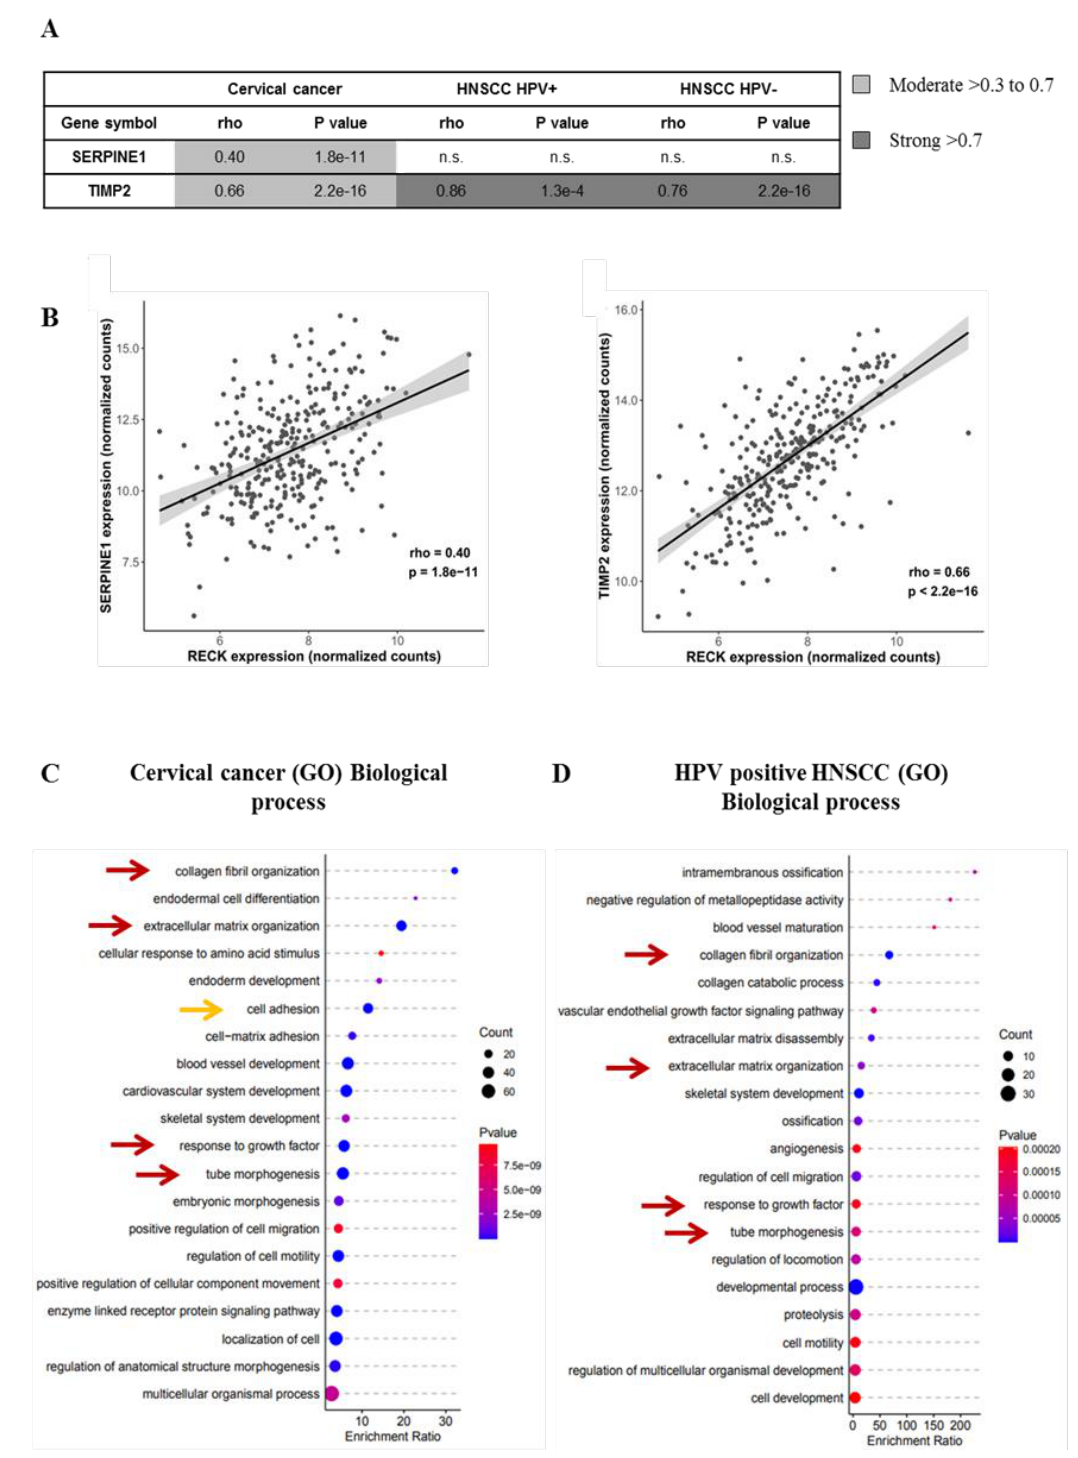
Figure 6. Extracellular matrix remodeling is one of the most enriched biological processes associated with RECK expression in both cervical cancer and HNSCC patients. ( A ). Correlation between SerpinE1 or TIMP2 mRNA levels and RECK mRNA expression in cervical cancer and HNSCC clinical samples deposited in TCGA platform. ( B ). Representative image of SerpinE1 and TIMP2 correlation with RECK expression in cervical cancer. Spearman’s correlation analyses between RECK and TIMP2 or RECK and SERPINE1/PAI1 mRNA levels in both cervical cancer and HNSCC patients from TCGA database. ( C , D ). GO enrichment analysis focused on biological processes most associated with RECK expression in cervical cancer ( C ) and HPV positive HNSCC clinical samples ( D ). Red arrows show biological processes enriched in cervical cancer and HNSCC. Orange arrow indicates the enrichment of the cell adhesion process in agreement with animal model